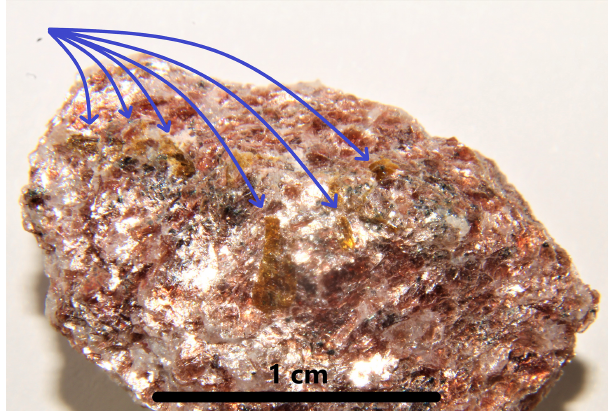
Figure 2. Ardennite in a red mica schist matrix from Nežilovo, North